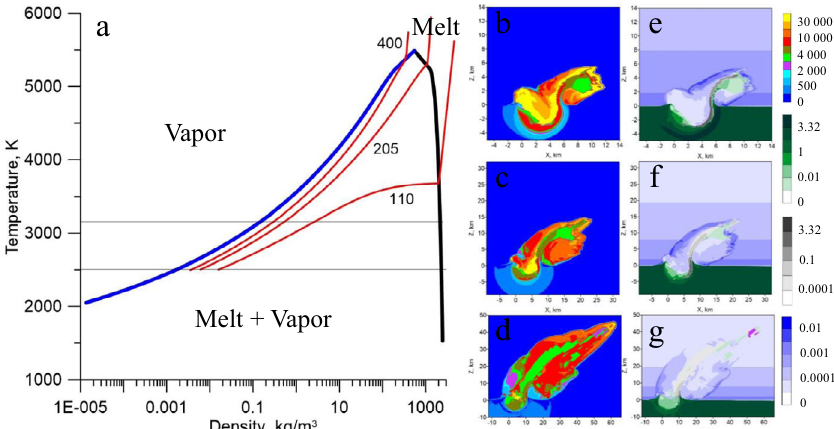
Fig. 6 Temperature and density in the Australasian impact plume. a - black and blue lines show the phase boundaries of quartz as calculated by the ANEOS package. The black branch represents saturated liquid, while the blue branch denotes saturated vapor. Red lines show release adiabats after shock compression to 110, 205, and 400 GPa. Thin horizontal lines correspond to the atmospheric pressure at sea level (10 − 4 GPa) and at an altitude of 30 km (10 − 6 GPa). The ejected materials with shock pressures below ~300 GPa, start to boil when the pressure is released. When the shock compressions are above ~300 GPa, the ejected material condenses during pressure release. The fraction of vapor remaining after the release is 0.1, 0.28, and 0.45, respectively. b – d – Temperature cross-sections of the plume through the plane of symmetry XZ at time frames of 0.5, 1.5, and 4.6 s following the impact at 45°. e – g – density cross sections of the impact plume at the same timeframes. Target materials are shown in green, projectile in gray and the atmosphere in